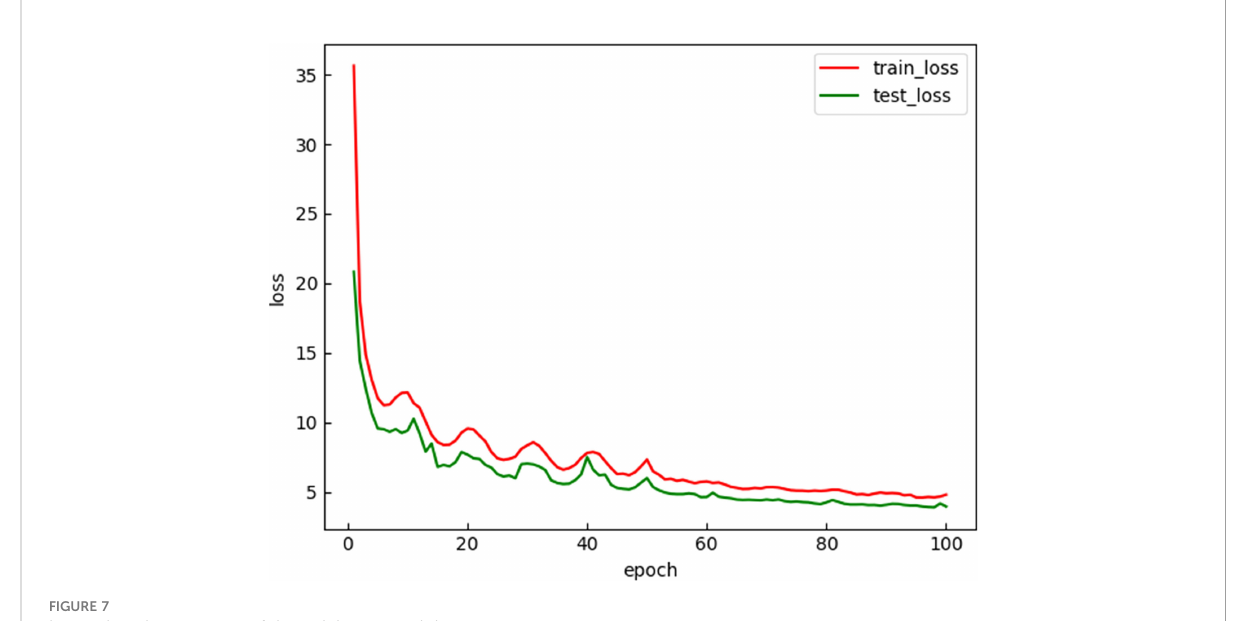
FIGURE 7 Loss value change curve of the training set and the test